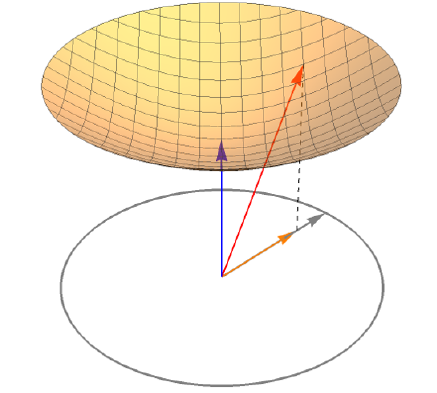
Figure 7. The unit spacelike vector n B ( u ) (shown in gray) determined by the unit timelike 3-vector (cid:4)( u ) (shown in red) and a timelike 3-vector B (shown in blue); the projection (cid:4) B ( u ) is shown in orange. We also show the future sheet of the unit hyperboloid. As u varies in D, the vector n B ( u ) describes a circle of unit radius (shown in gray) contained in the spacelike plane orthogonal to B ; one can think of the function ! as being de(cid:12)ned on this circle. The (cid:12)gure shows the case when B is future-pointing with ( B; B ) =